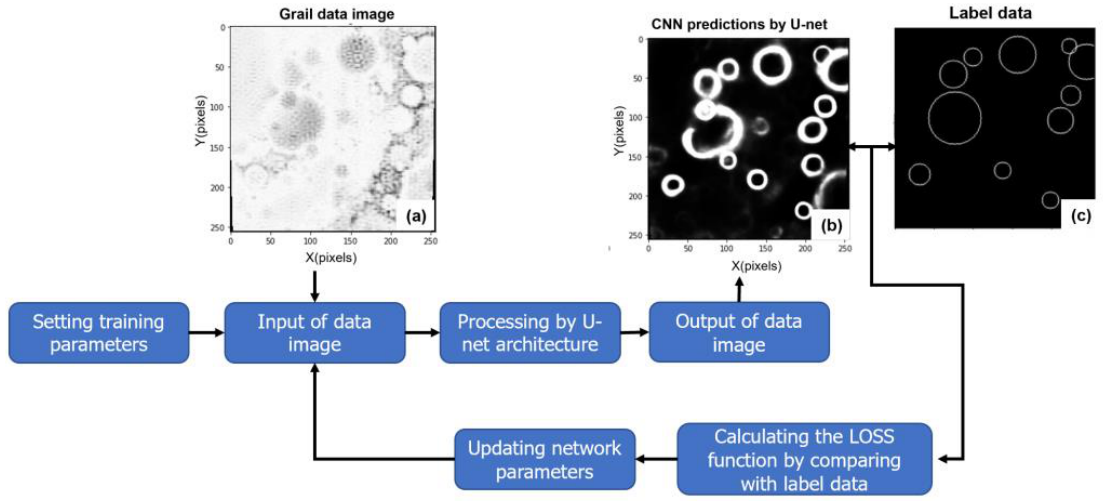
Figure 6. The flow chart of the train process by U-net architecture (( a ) denotes the GRAIL gravity data image, ( b ) denotes CNN prediction by U-net; ( c ) denotes the label data where the circle mean the shapes of the impact craters).